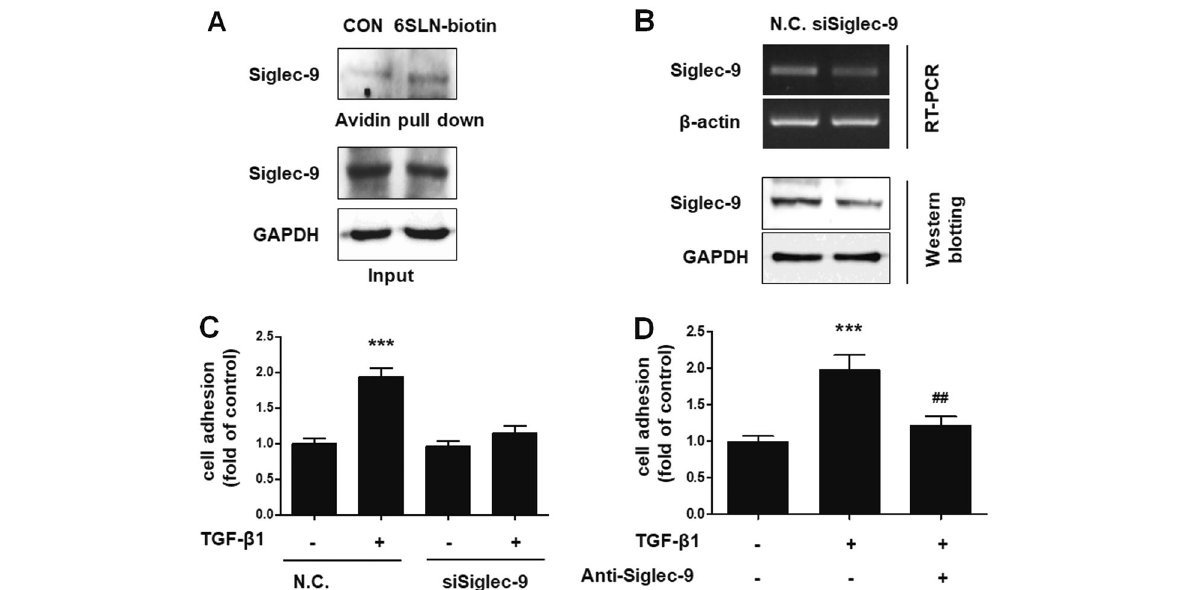
Fig. 5 6 ʹ -SLN ligands on the endometrial cells engaged Siglec-9 on Met-5A cells a To con fi rm binding between 6 ʹ -SLN and Siglec-9, cell lysates from Met-5A cells were subjected to a pull-down assay using biotin-labeled 6 ʹ -SLN and incubated with avidin beads. Proteins binding to the avidin beads were resolved and subjected to western blot analysis. b Met-5A cells were incubated with siRNA targeting Siglec-9 for 24 h. Expression of Siglec-9 in Met-5A cells was assessed by RT-PCR and western blot analysis. c siSiglec-9-transfected Met-5A cells were cultured to a con fl uent monolayer. Tracker ™ Green CMFDA-labeled Ishikawa cells were added to the monolayer and incubated for 20 min. Adhered Ishikawa cells were manually counted, and the results are expressed as the fold-difference relative to the control (mean± SD). d Ishikawa cells were treated with TGF- β 1 (10 ng/mL) for 48 h. Met-5A cells were incubated with neutralizing anti-Siglec-9 antibody (2 μ g/mL) 24 h before the adhesion assay. Fluorescence- labeled Ishikawa cells were added onto Met-5A cells. After 20 min of incubation and then washing, attached cells were manually counted, and the results are expressed as the fold-difference relative to the control. ** p < 0.01 and *** p < 0.001 compared with the control group. ## p < 0.01 and ### p < 0.001 compared with the TGF- β 1-treated